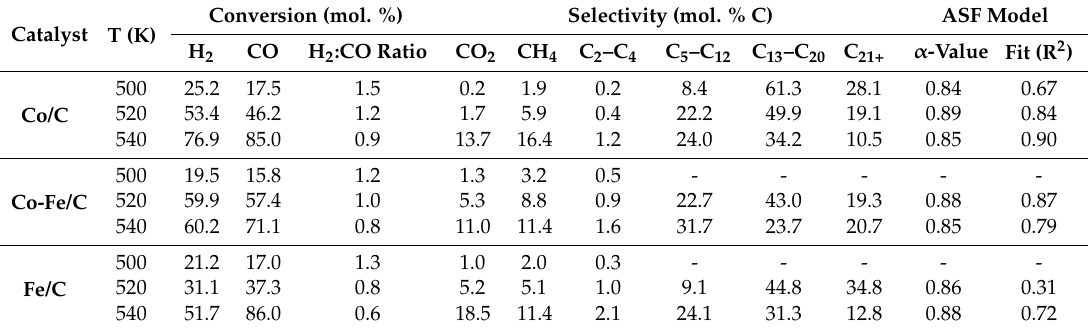
Table 1. The summarized performance data of the Co/C, Fe/C and 50%Co-50%Fe/C catalysts tested